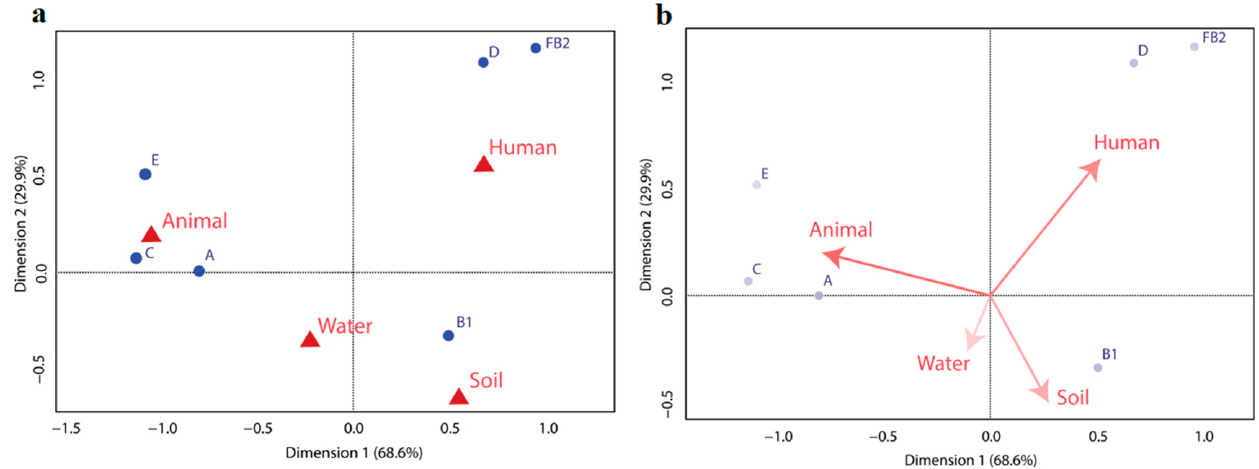
Figure 2. Correspondence analysis. ( a ) The bi-dimensional graph represents 98.43% of the total variation, with 68.58% explained by first dimension, and 29.85% by the second dimension. The phylogenetic groups are represented as blue/purple circle, whereas the isolate habitats are represented as red triangles/arrows. ( b ) In case of the asymmetric map, the length and brightness intensity of the circles correlates with the occurrence of the phylogenetic groups. The arrows between any two samples and the origin (the point of intersection of the dimensions) created angles. The sharper the angle, the more related the habitats are in case of E. coli phylogenetic group distribution.